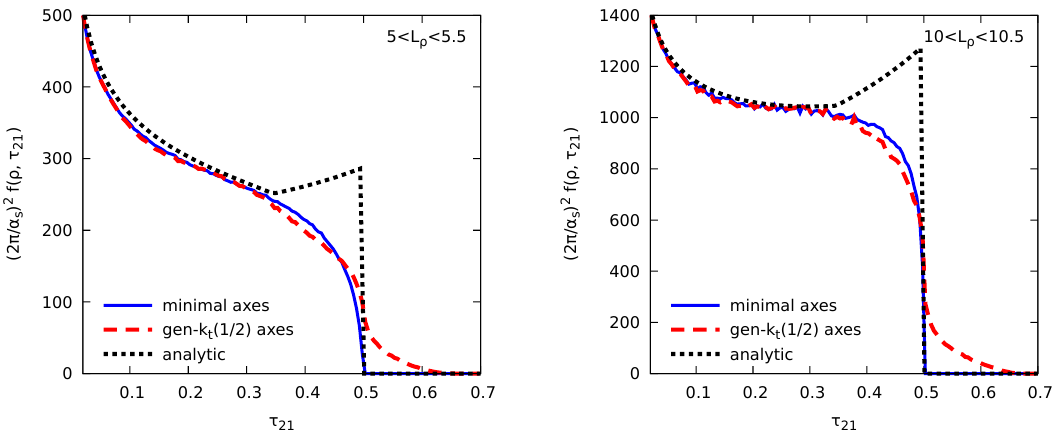
Figure 3 . Comparison of our analytic results (dotted black) with the Event2 generator for the (cid:28) 21 distribution in a bin of (cid:26) . For the Event2 simulations, we show results for both the minimal axes (solid blue) and generalised- k t axes (dashed red). The left and right plots corresponds to di(cid:11)erent bins in L (cid:26) = log(1 =(cid:26)